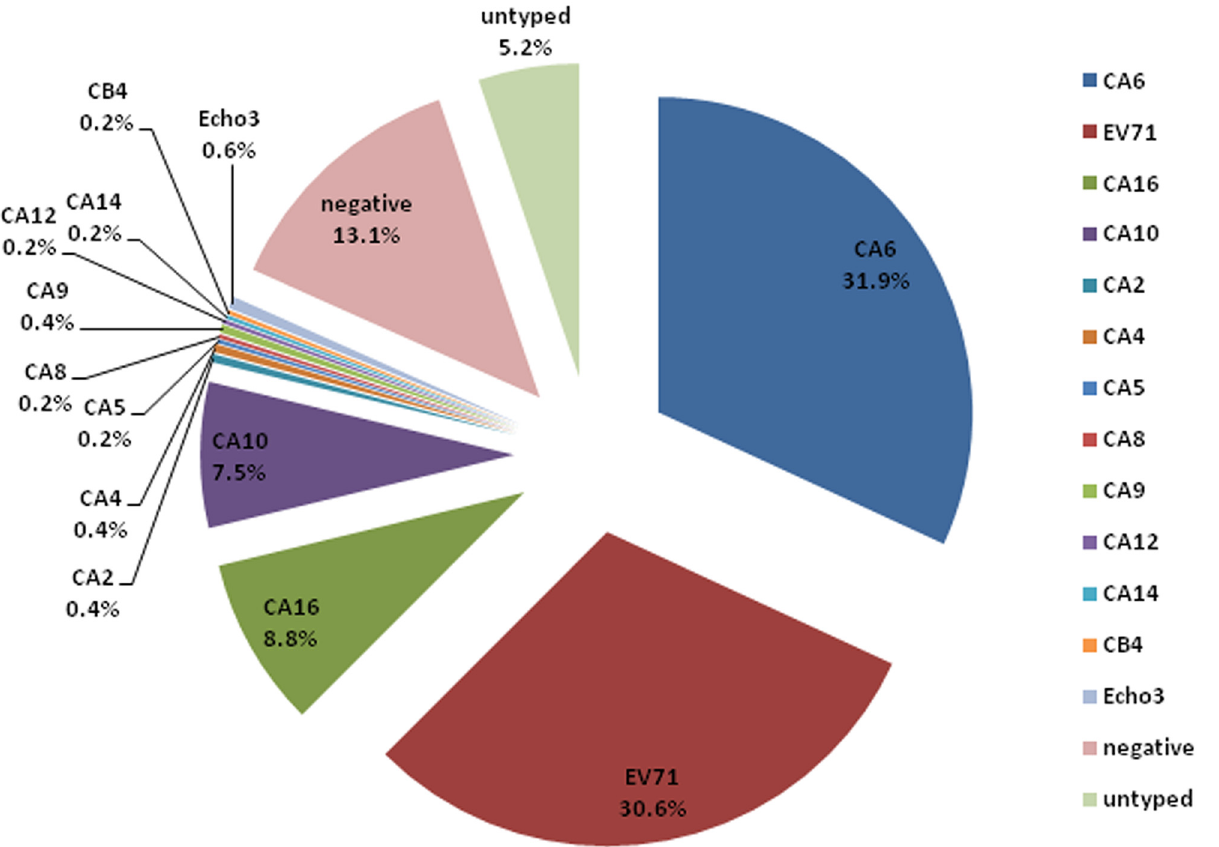
Fig 1. The genotypes of enteroviruses identified in HFMD patients from 2012 to 2013, Shanghai,